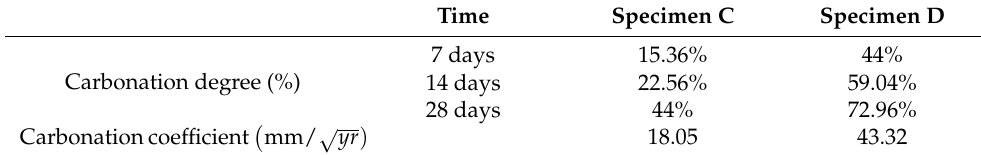
Table 3. Carbonation degree (%) and carbonation coefficient value of paste specimens.